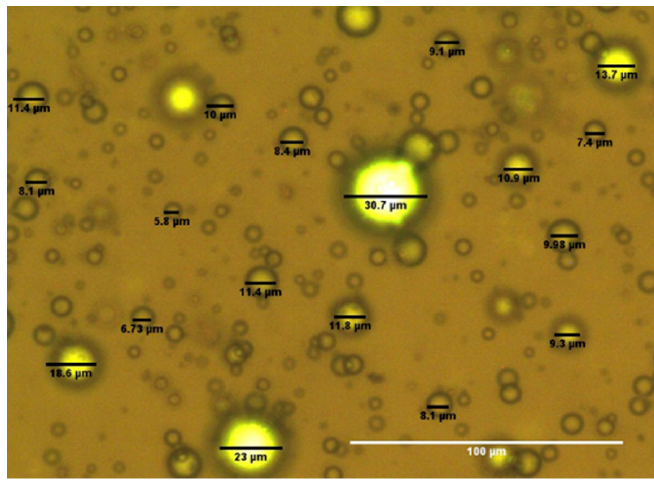
Figure 25. Sample P with 18% ( v / v ) water added. Dg average = 16.6 µm ± 0.01. Analyzing the results, the N system presents the best results with 7–9.9 µ m ± 0.01. The results indicate that the P system achieved the greater CO emissions (54.4% reduction) and savings in specific fuel oil consumption of 1% in process model scenario I (8.5 MW. 15% v / v water) and 56.7% of CO emission reduction and 2.7% of specific fuel consumption savings in process model II (8.5 MW. 18% v / v